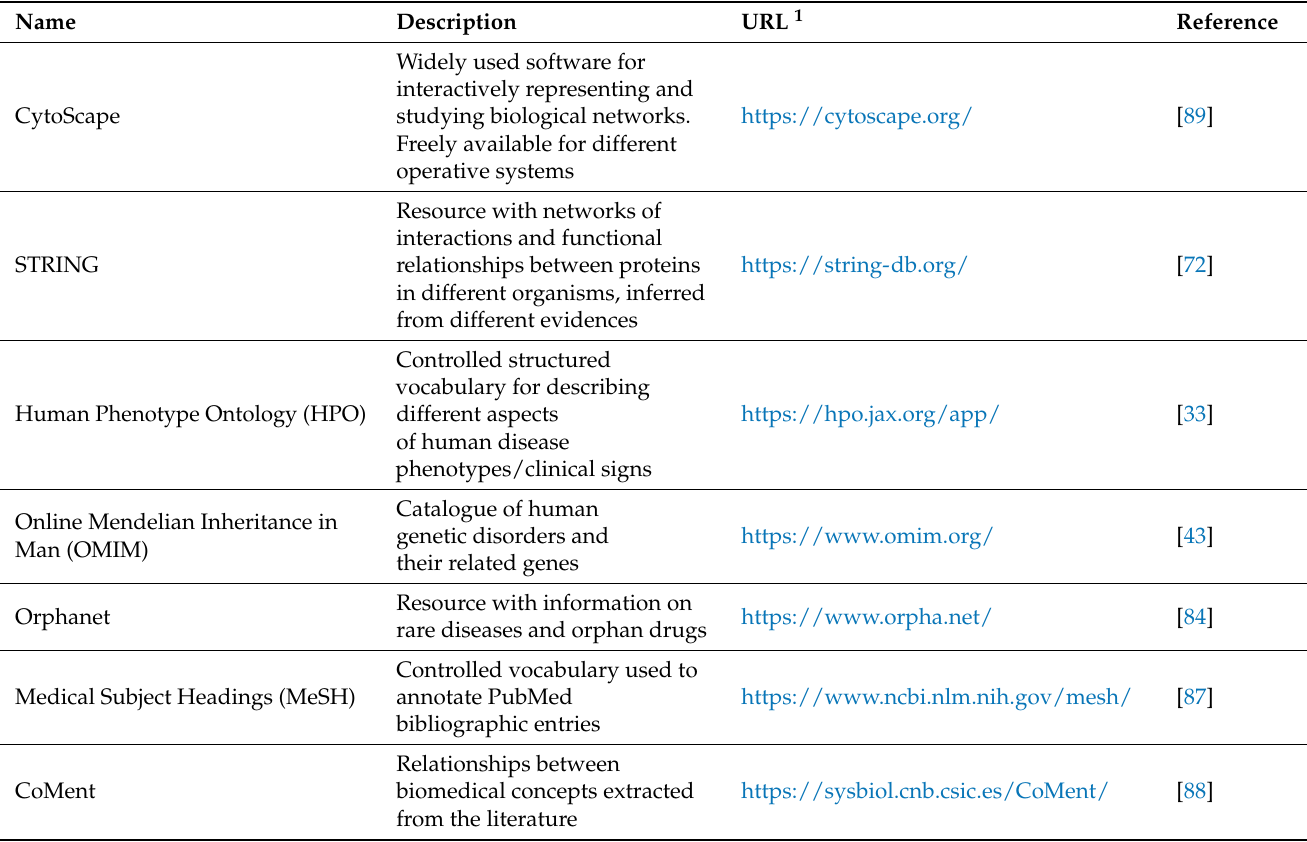
Table 1. Main online resources related to network approaches to diseases and